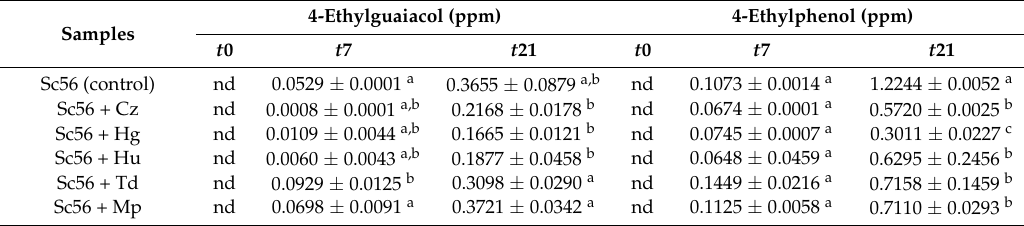
Table 3. Volatile phenol content (ppm) of grape musts spiked with B. bruxellensis Unifg 8 and inoculated with different combinations of S. cerevisiae KT029756 with non- Saccharomyces strains ( Candida zemplinina KT029748, Hanseniaspora uvarum KT029770, Hanseniaspora guilliermondii KT029766, Torulaspora delbrueckii KT029800 and Metschnikowia pulcherrima KT029783) during AF: t 0, day of inoculation; t 7, 7 days from the inoculation; t 21, 21 days from the inoculation (nd, volatile phenol not detected). Results of the ANOVA analysis are shown as letters on the data corresponding to the concentration of volatile phenols: different letters on the same column indicate significant differences of 95%.